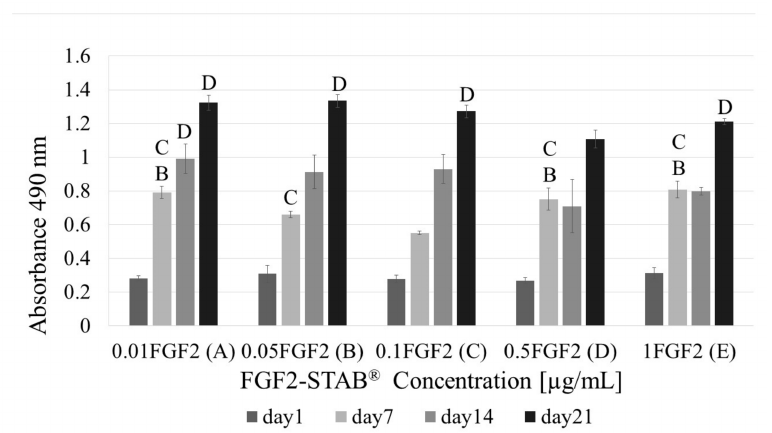
Figure 8. Fibroblast metabolic activity with increasing FGF2-STAB ® concentration (0.01, 0.05, 0.1, 0.5 and 1 µ g/mL for A – E , respectively) after 1, 7, 14 and 21 days of incubation. Statistical significance for p < 0.05 is shown above